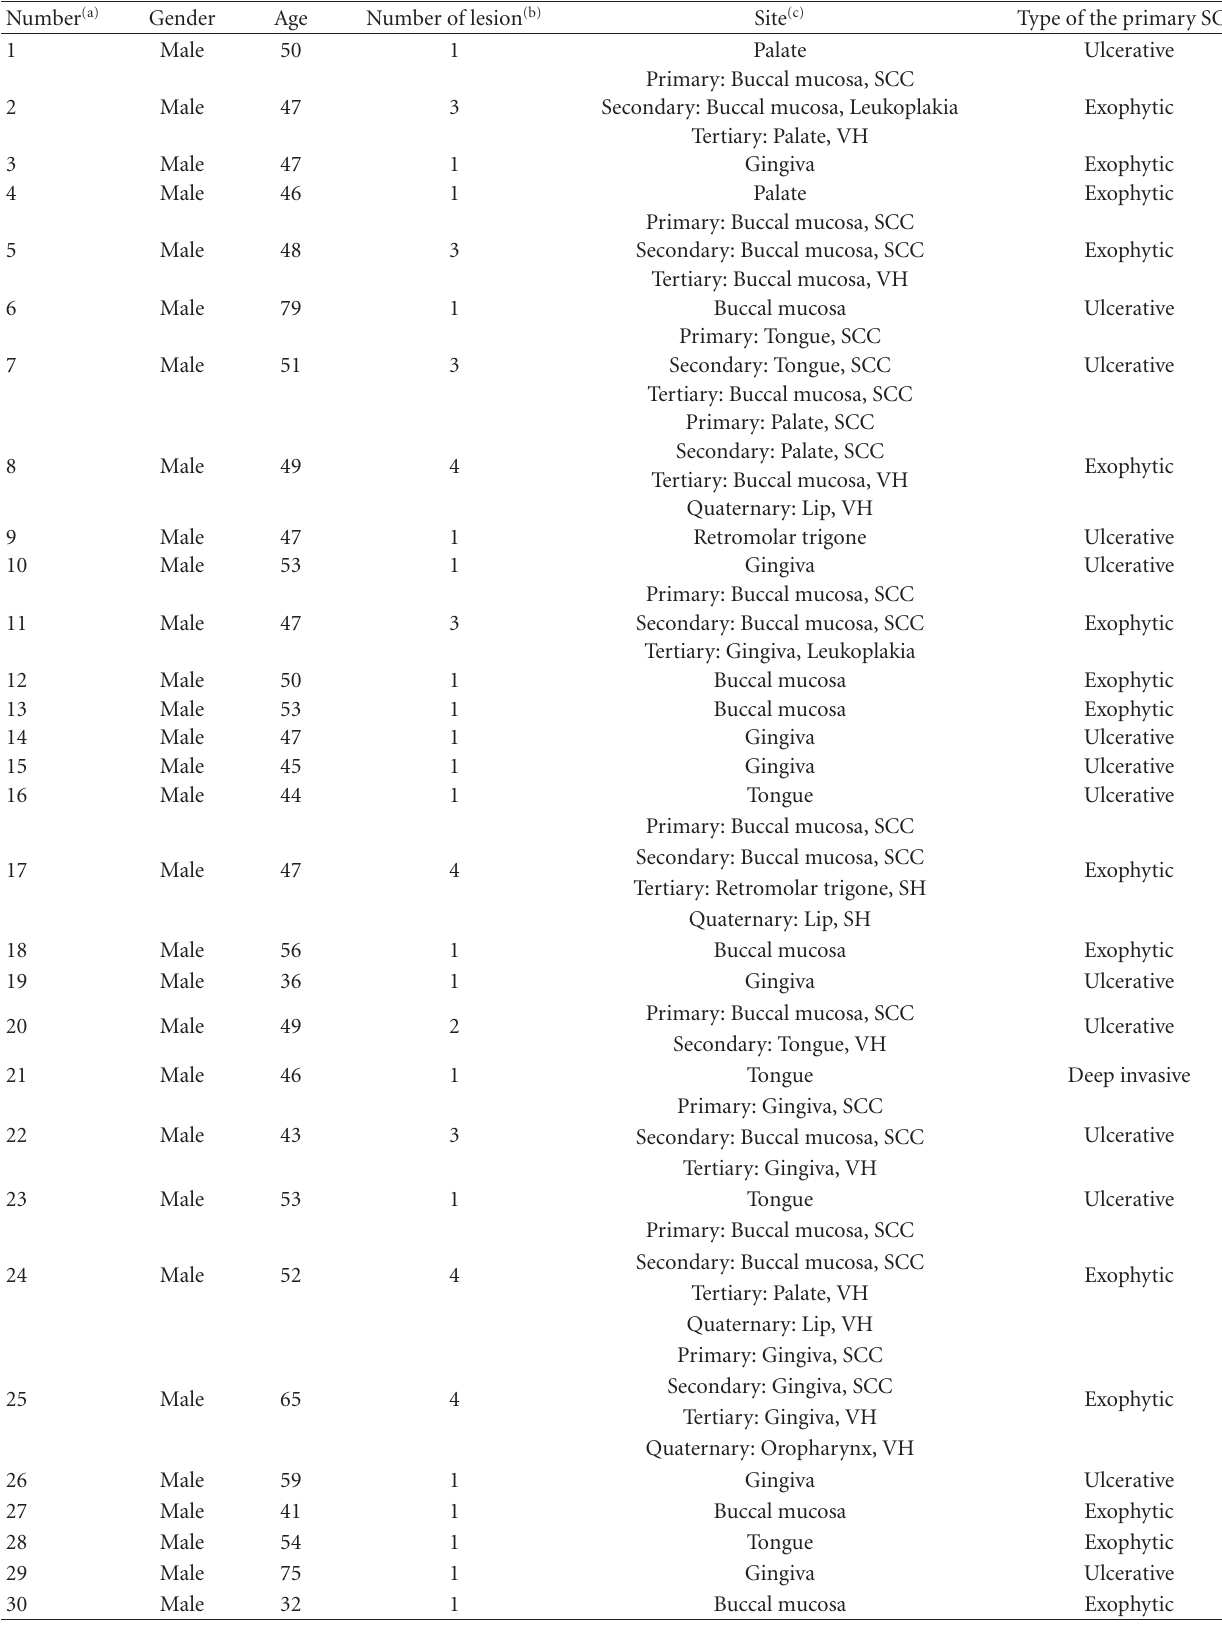
Table 1: Characteristics of patient subjects participated in EBV-chip